Question: Condense the content of this figure into a single sentence.
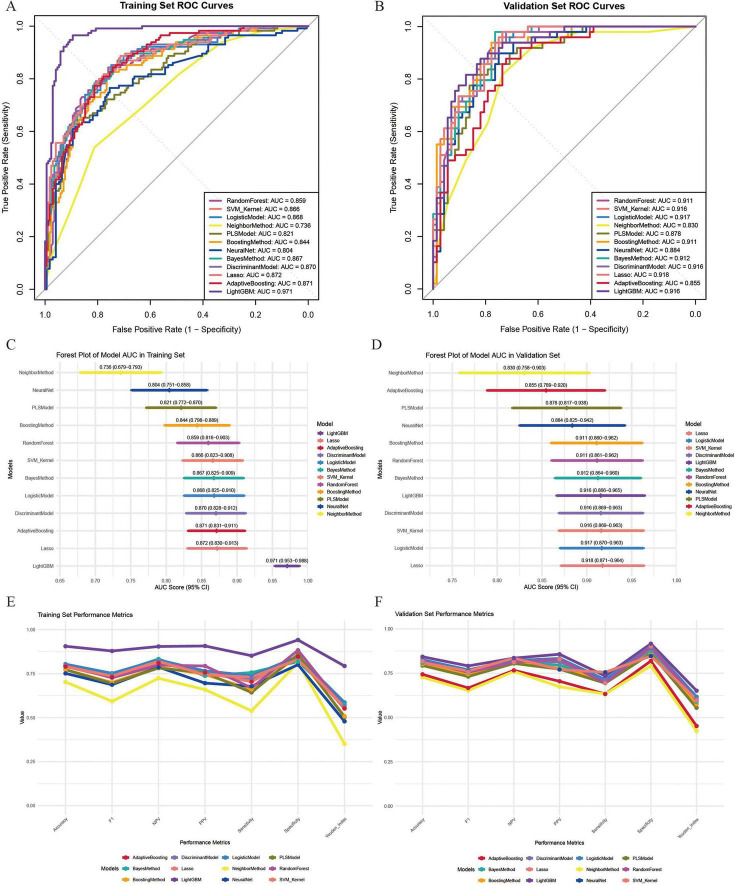
Answer: Discrimination and classification performance of machine learning models in the training and validation sets. (A) ROC curves in the training set. (B) ROC curves in the validation set. (C) Forest plot of AUC values in the training set. (D) Forest plot of AUC values in the validation set. (E) Comparison of classification performance metrics in the training set. (F) Comparison of classification performance metrics in the validation set.